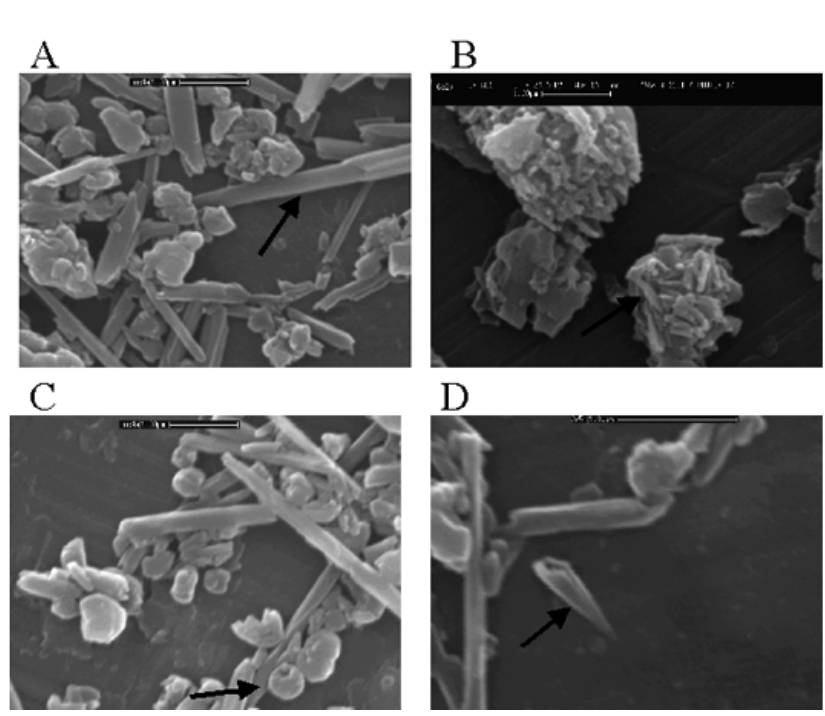
Fig. 8 – Variety of halloysite morphologies: tubes (A), small tubes between kaolinite plates (B), spheres that are scarce (C) and partly rolled tube or cone (D). Graphic Scale = 1 µ